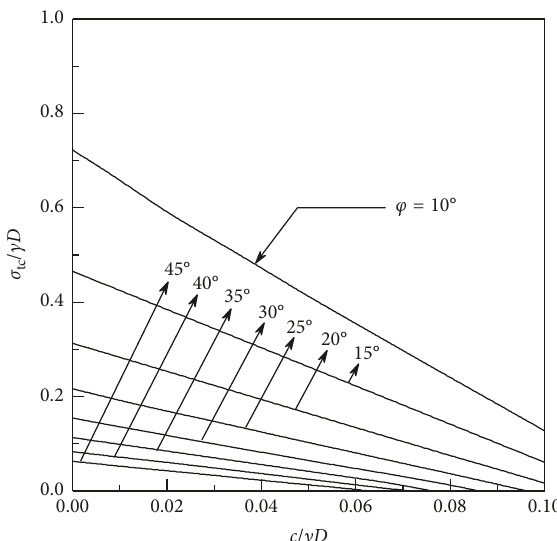
Figure 8: Stability charts of the critical pressure supported on the tunnel face.